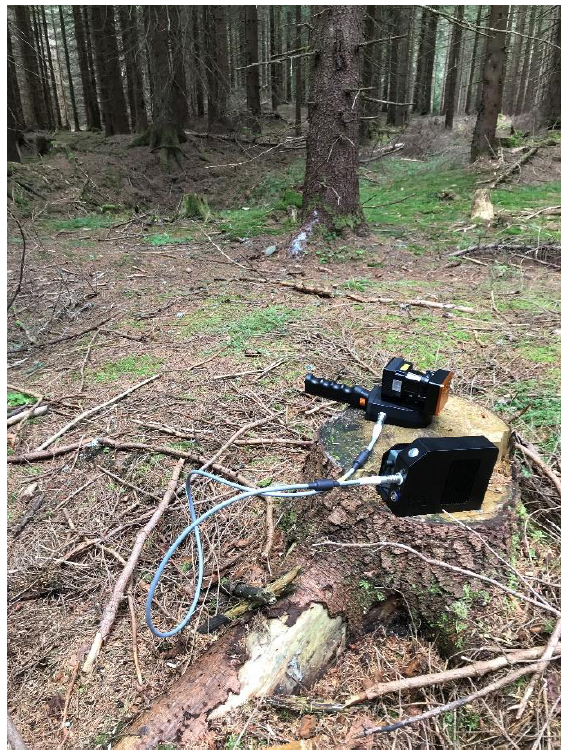
Figure 7. The ZEB-REVO personal mobile laser scanner with cable, battery, and integrated data storage